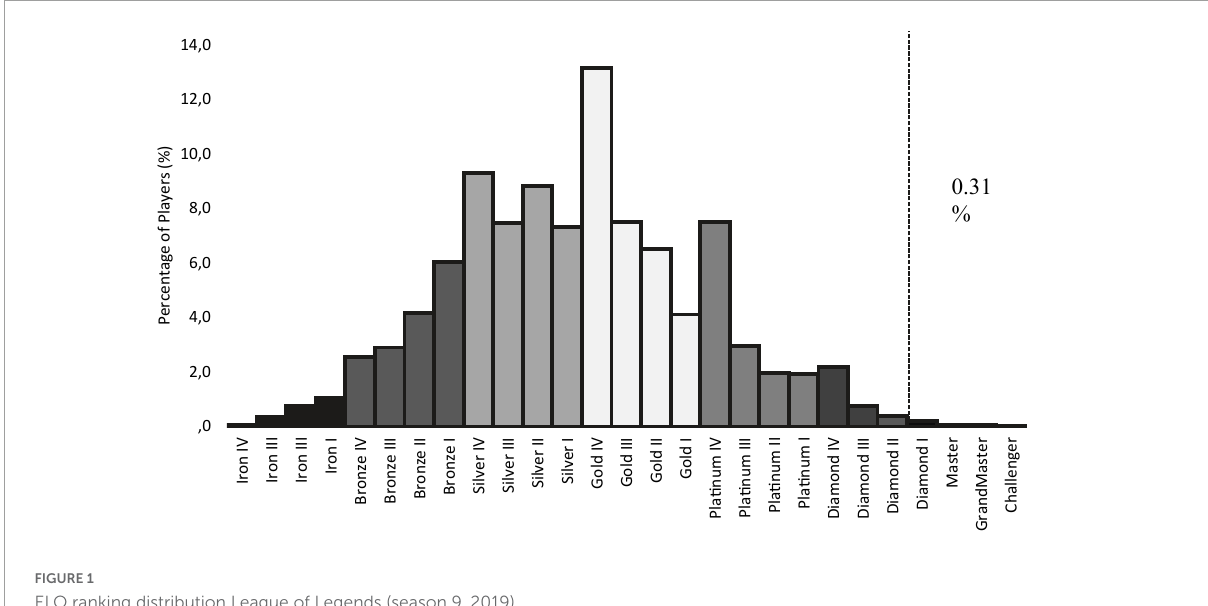
FIGURE1 ELO ranking distribution League of Legends (season 9,